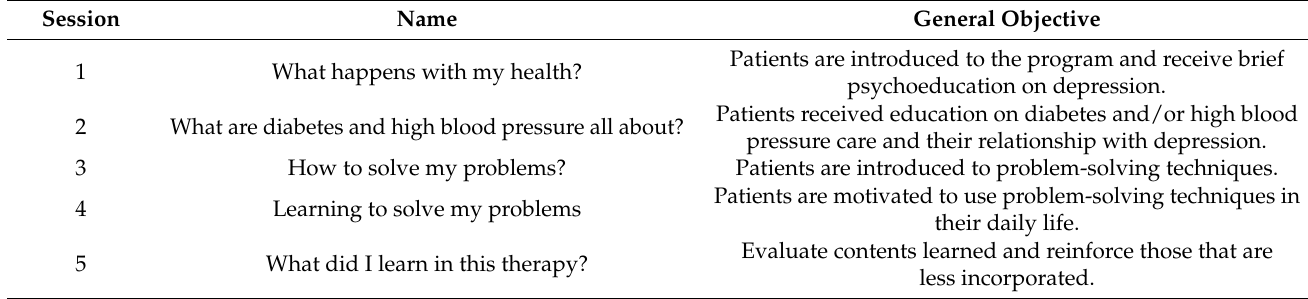
Table 1. Structure of the computer-assisted psychosocial